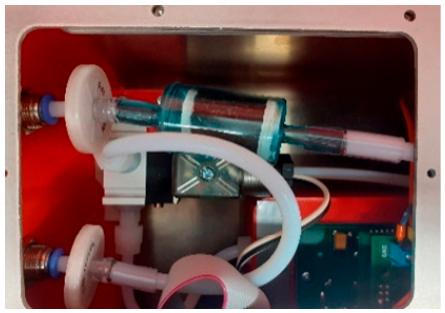
Figure 3. The interior of gas sensing device. Top—the gas line used for delivering the cleaned am- bient air for sensors regeneration; Teflon filter and charcoal filter were mounted on this line. Bottom —the gas line used for delivering gas sample; only Teflon filter was mounted on this line.